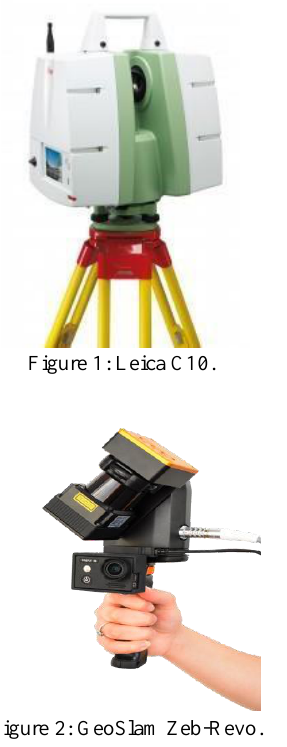
Figure 2: GeoSlam